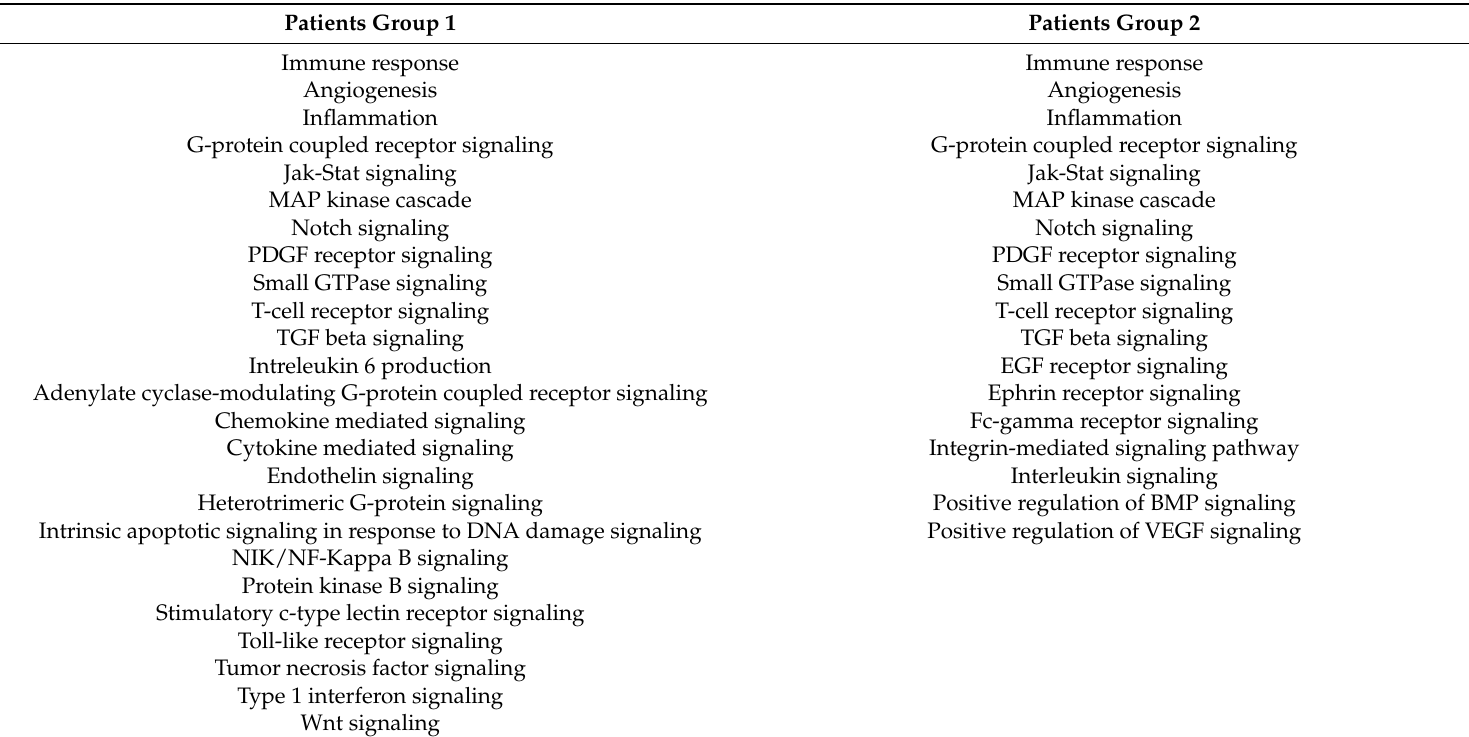
Table 4. Molecular signalings in which are involved genes modulated only before